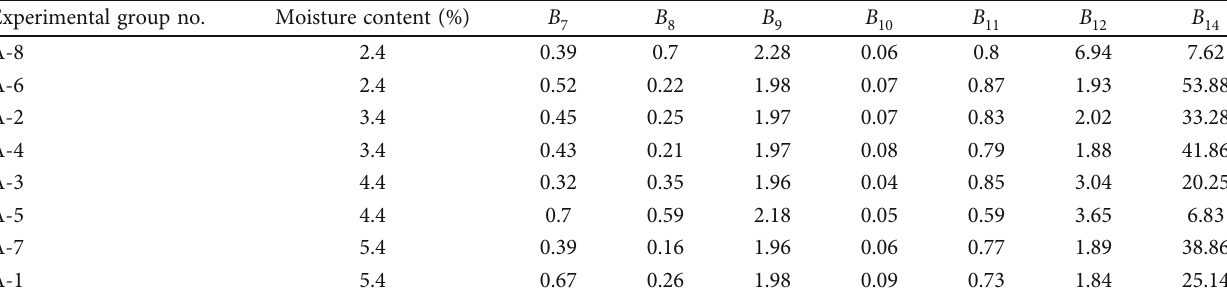
Experimental group no.